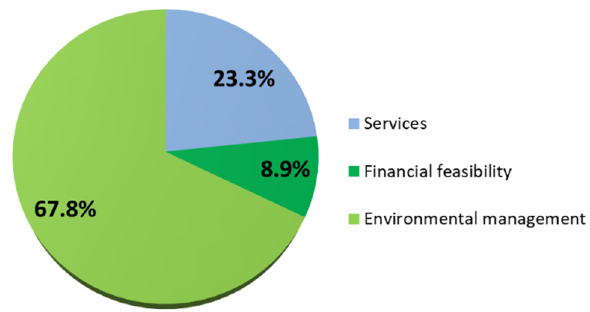
Figure 2. Management subjects related to papers.